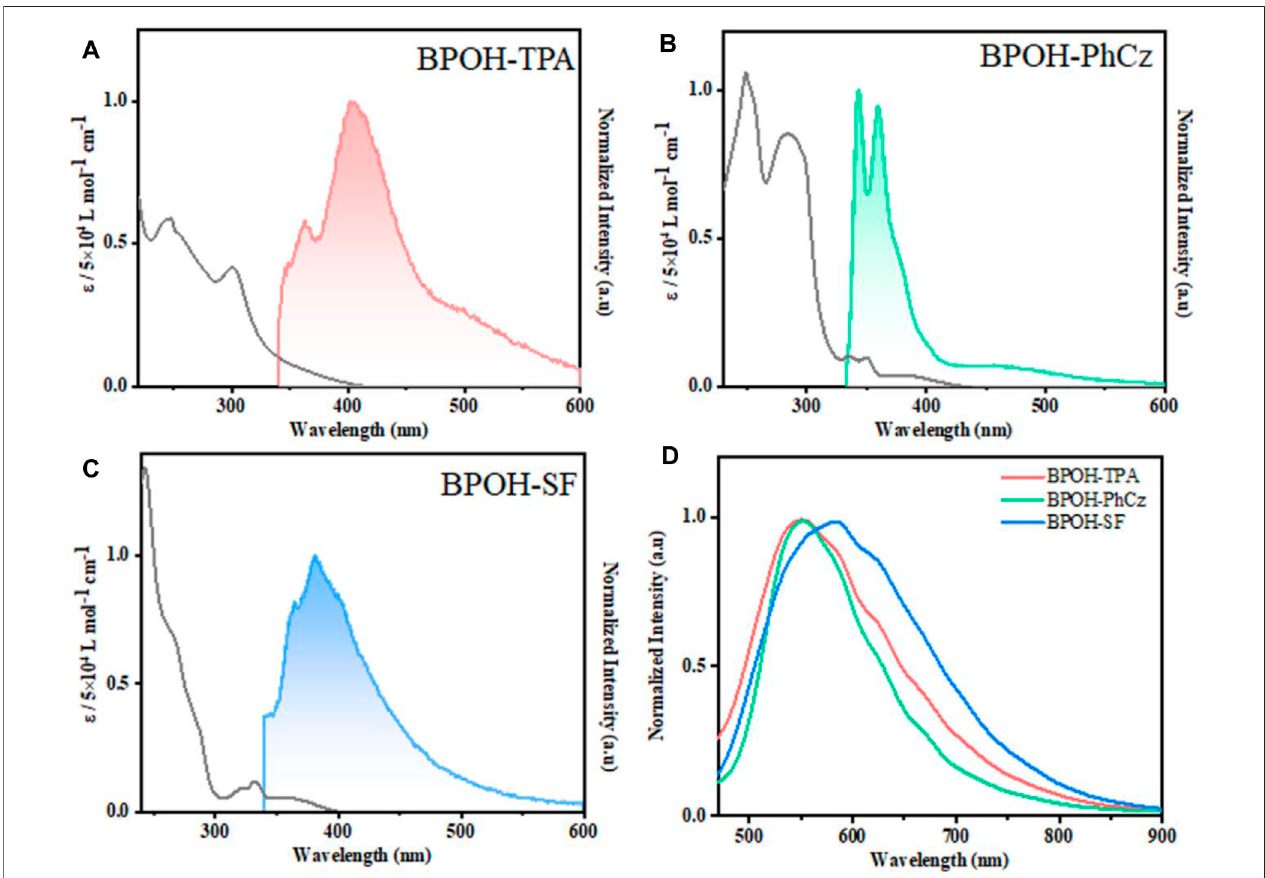
FIGURE 2 | Absorption (black) and fl uorescence spectra of (A) BPOH-TPA, (B) BPOH-PhCz, and (C) BPOH-SF in THF at a concentration of 2.0 × 10 − 5 mol L − 1 ( λ ex (cid:2) 295 nm). (D) The emission spectra of BPOH-TPA, BPOH-PhCz, and BPOH-SF in powder states ( λ ex (cid:2) 365 nm).